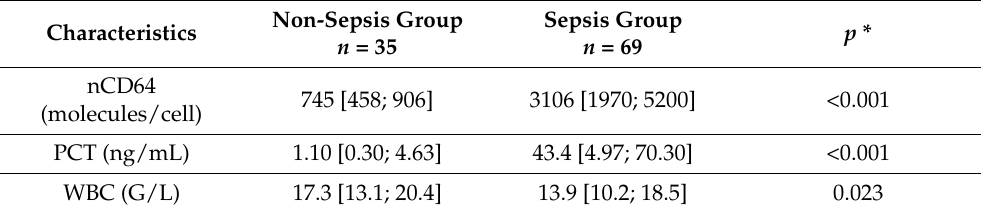
Table 2. Distributions of levels of nCD64, PCT, and WBC in the sepsis and non-sepsis groups.